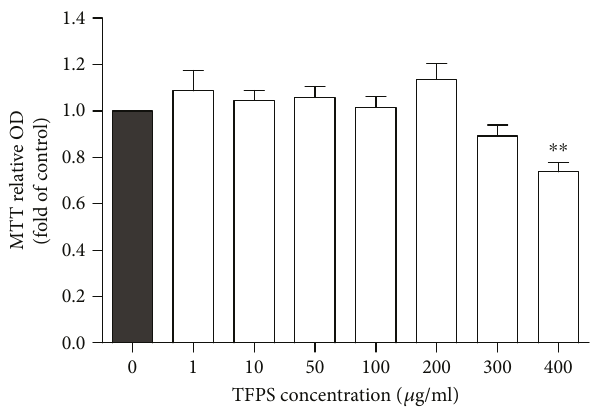
Figure 3: Cytotoxicity of Tremella fuciformis polysaccharide in RAW264.7 cells. RAW264.7 cells were cultured in the presence of TFPS (0, 10, 50, 100, 200, 300, and 400 μ g/ml) for 24 h; cell viability was assessed using MTT assays ( n = 3 , ∗∗ P < 0 01 versus the control